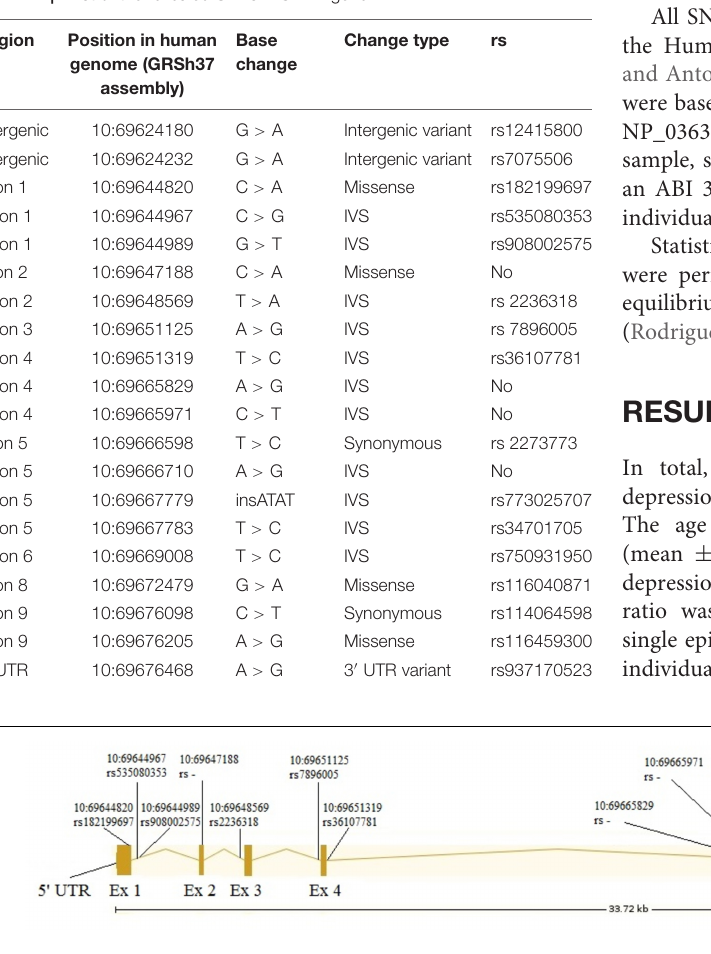
FIGURE 1 | Distribution of genetic variants in the SIRT1